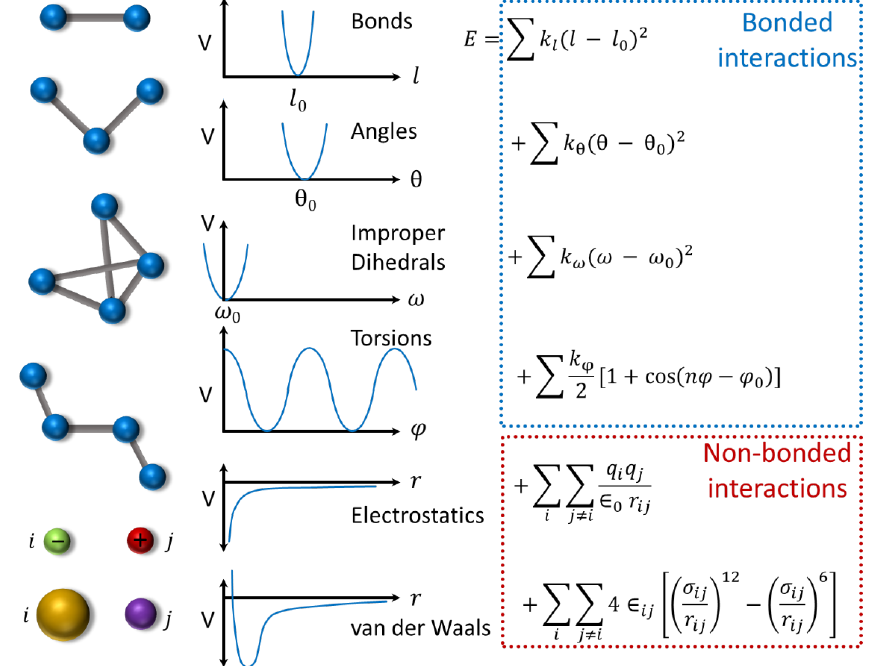
Figure 4. Typical form of a molecular force-field constituted by bonded (bond, angle, dihedral, and torsion) interactions and nonbonded (electrostatic and van der Waal’s) interaction energy terms. The force filed parameter set include: equilibrium bond length (𝑙 0 ) , bond angle (𝜃 0 ) , dihedral angle (𝜔 0 ) , torsion angle ( 𝜑 0 ) , and their respective force constants, 𝑘 𝑙 , 𝑘 𝜃 , 𝑘 𝜔 , and 𝑘 𝜑 , as well as charge (𝑞 𝑖 ) on each atom 𝑖 , dielectric constant (𝜖 0 ) , strength of dispersion interactions ( (cid:15) ij ) , and contact distance (𝜎 ) between the atoms 𝑖 and 𝑗 . The interatomic distance is represented by 𝑟 𝑖𝑗 .